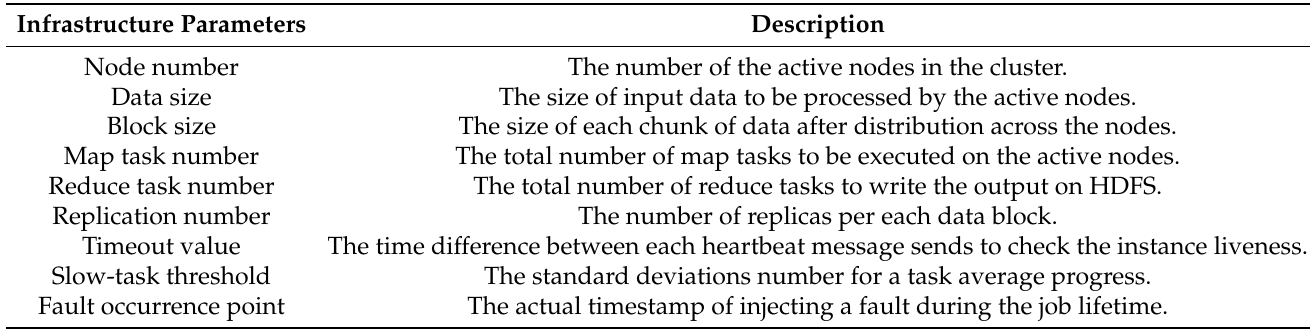
Figure 4. Fault scenarios in Hadoop MapReduce. Table 2. Brief description of the infrastructure parameters used in the